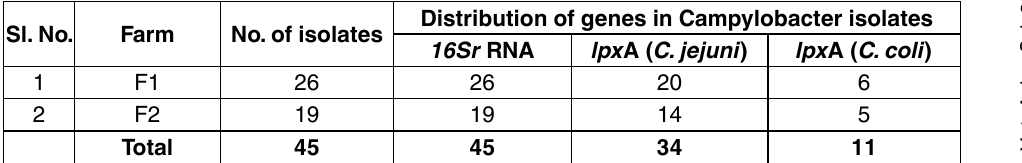
table 3. Distribution of Campylobacter spp. in layer farms sl.